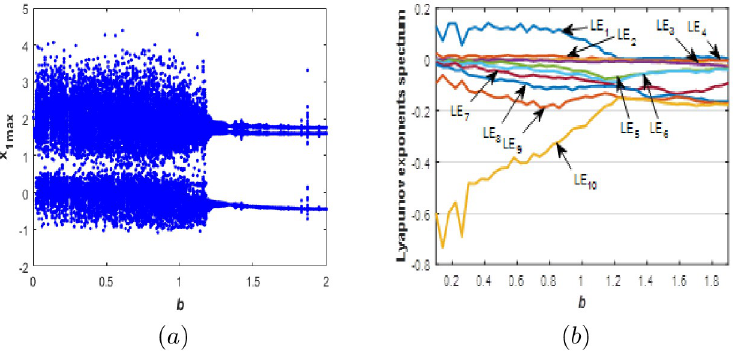
Fig 5. Bifurcation diagram (a) and Lyapunov exponents spectrum (b) of the new 10-D system (1) when: a = 0.1, c = 1.8, d = 0.01 and b 2